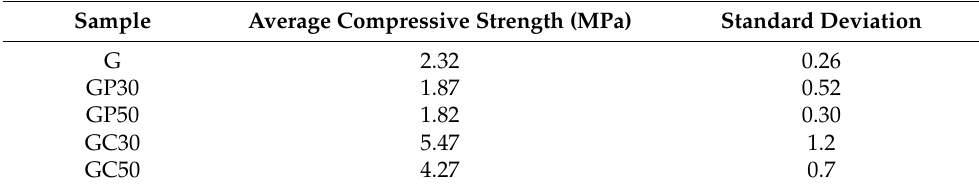
Table 5. Compressive strength of foamed geopolymer and composite materials with different com- positions.